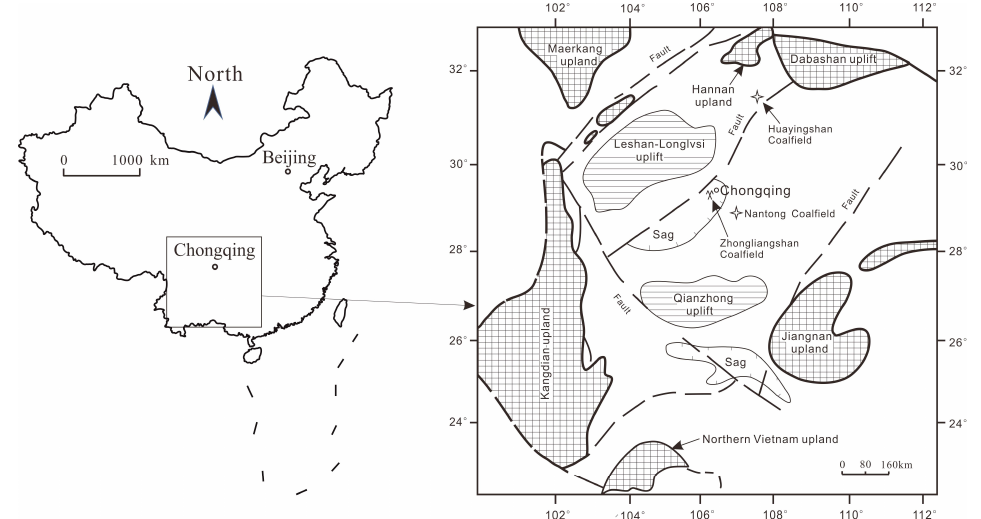
Figure 1. The location and tectonic map of the Zhongliangshan Coalfield.